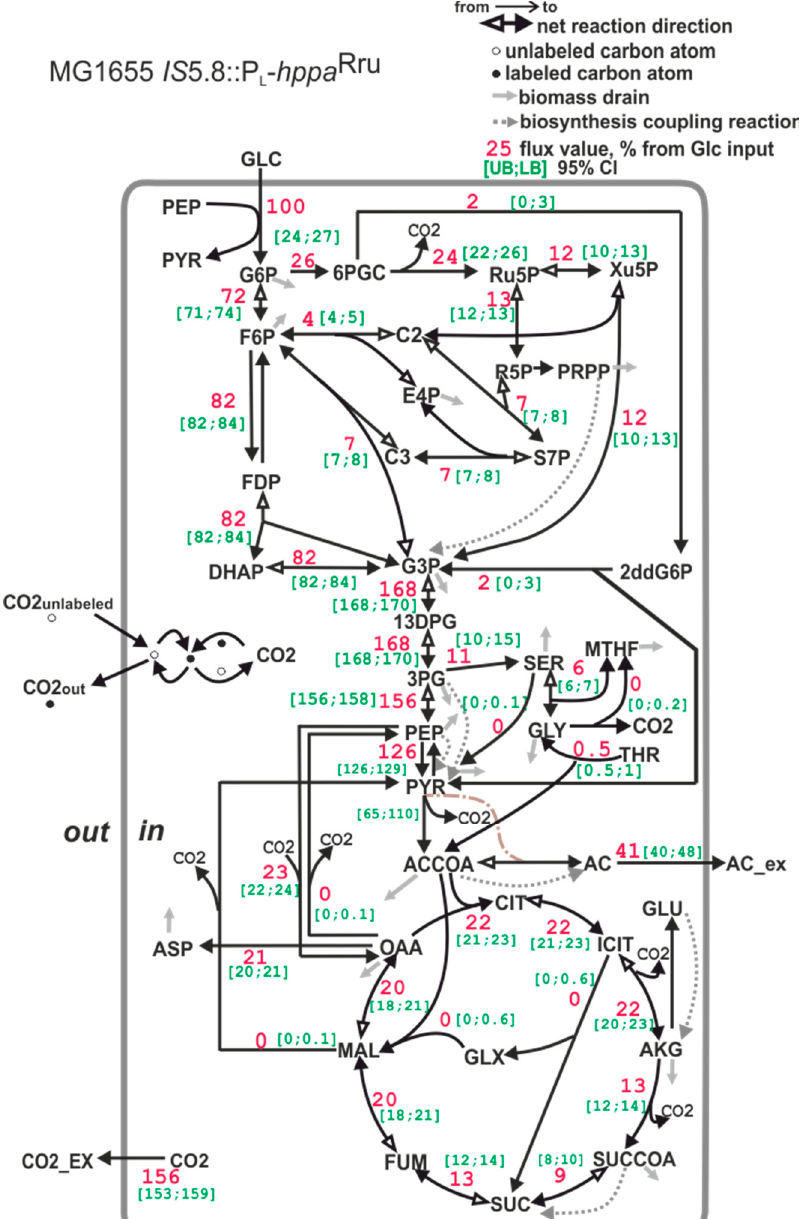
Figure 7. The carbon flux distribution in the E . coli MG1655 IS 5.8::P L - hppa Rru strain. For details, see the caption of Figure 6.